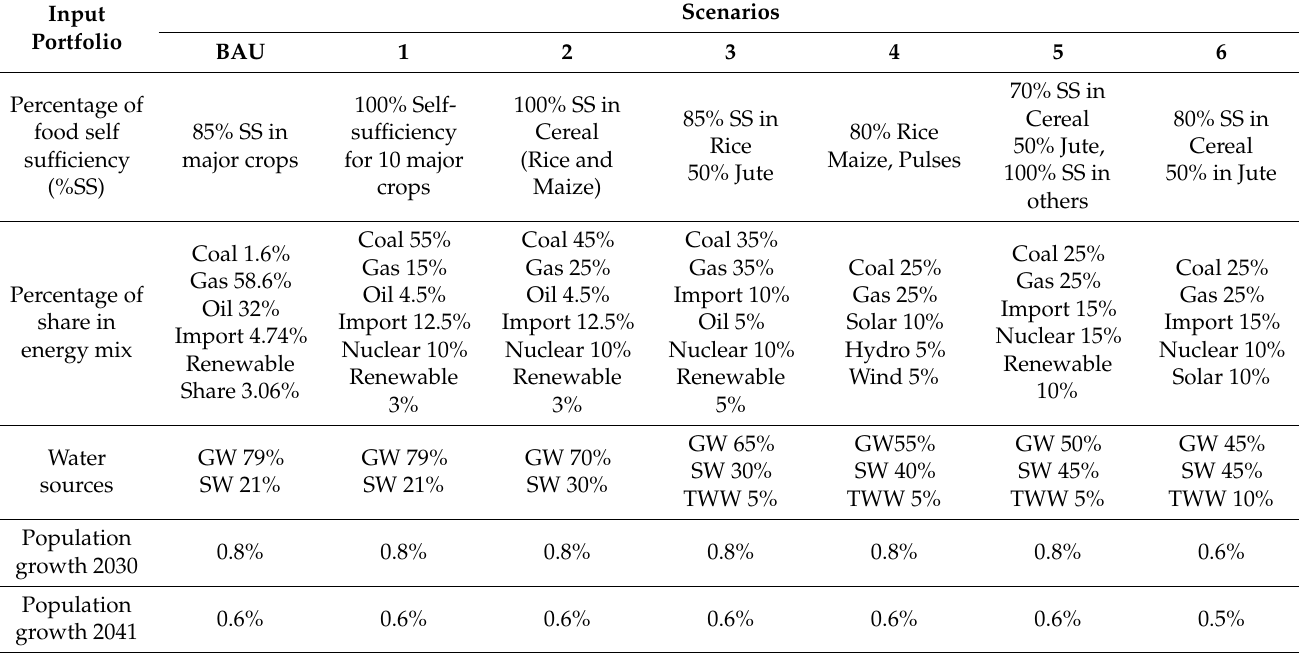
Table 2. Description of assessed